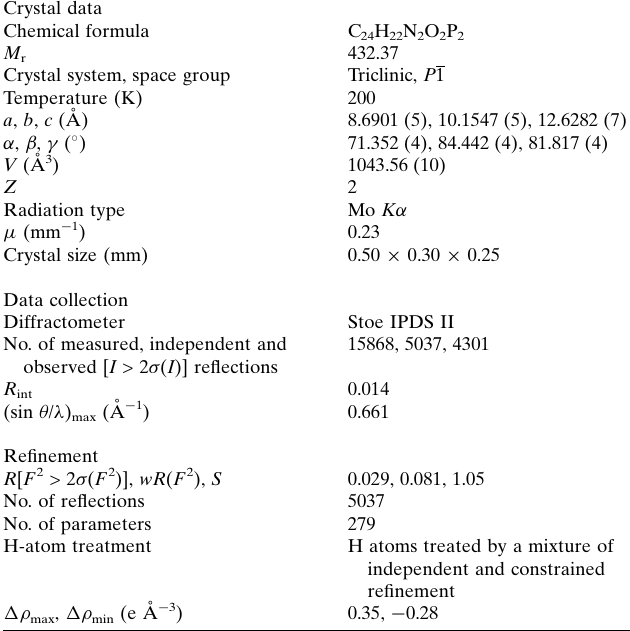
Table 2 Experimental details. Crystal data Chemical formula